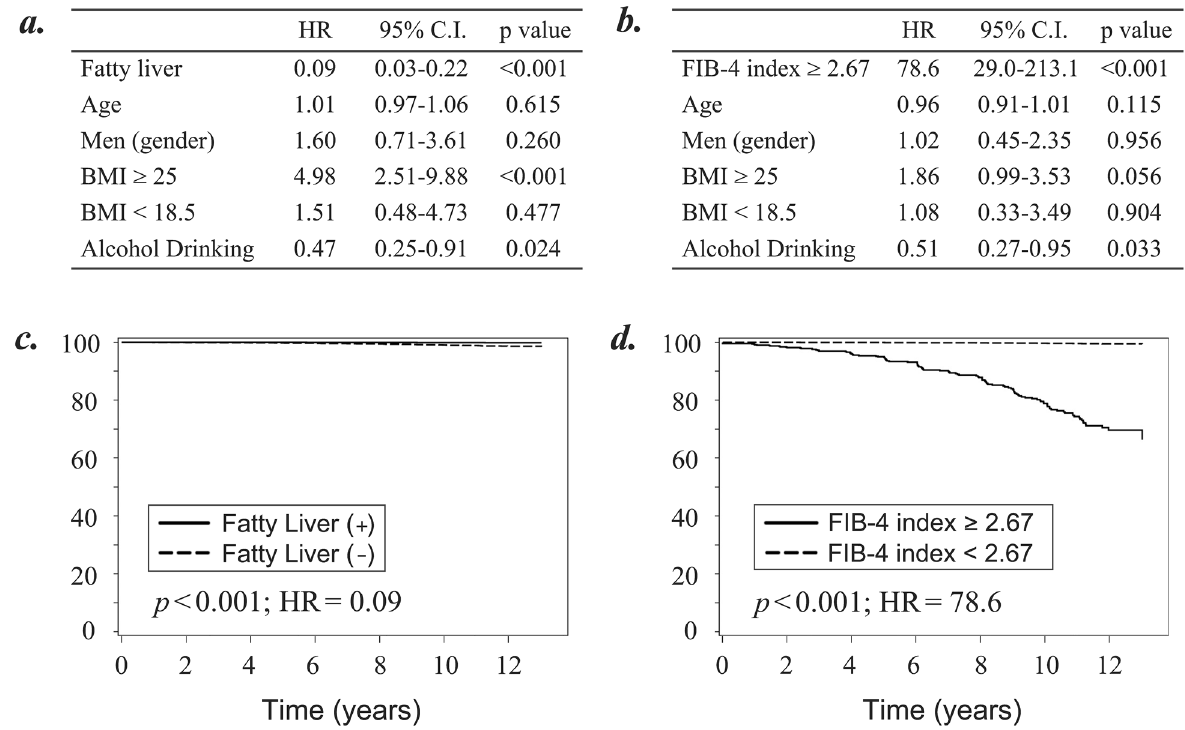
Figure 3. Cox regression analyses to evaluate the usefulness of fatty liver and FIB-4 index for prediction of chronic hepatitis development. ( a ) Cox regression analysis to evaluate chronic hepatitis development focusing on the presence of fatty liver. ( b ) Cox regression analysis to evaluate chronic hepatitis development focusing on the value of FIB-4 index. ( c ) Adjusted survival curves to evaluate the incidence of chronic hepatitis based on the Cox proportional hazards regression categorized by the presence of fatty liver. ( d ) Adjusted survival curves to evaluate the incidence of chronic hepatitis based on the Cox proportional hazards regression categorized by the value of FIB-4 index. All analyses were performed on the study participants after excluding those with chronic hepatitis, liver cirrhosis, and other diseases relating to liver, collagen, and hematological diseases at the time of entry. A p -value < 0.05 was considered statistically significant. HR hazard ratio; C.I. confidence